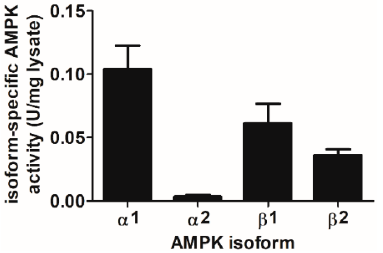
Figure 8. Activities of complexes containing specific AMPK isoforms in HAECs. AMPK was immunoprecipitated from HAEC lysates (100 µg) and AMPK activity assessed in immunoprecipitates by incorporation of 32 P from [ γ - 32 P]ATP into SAMS peptide. AMPK activity is presented as U/mg lysate protein (1 U = 1 nmol 32 P incorporated into SAMS peptide/min). Results shown are mean ± SEM activity from three independent experiments.